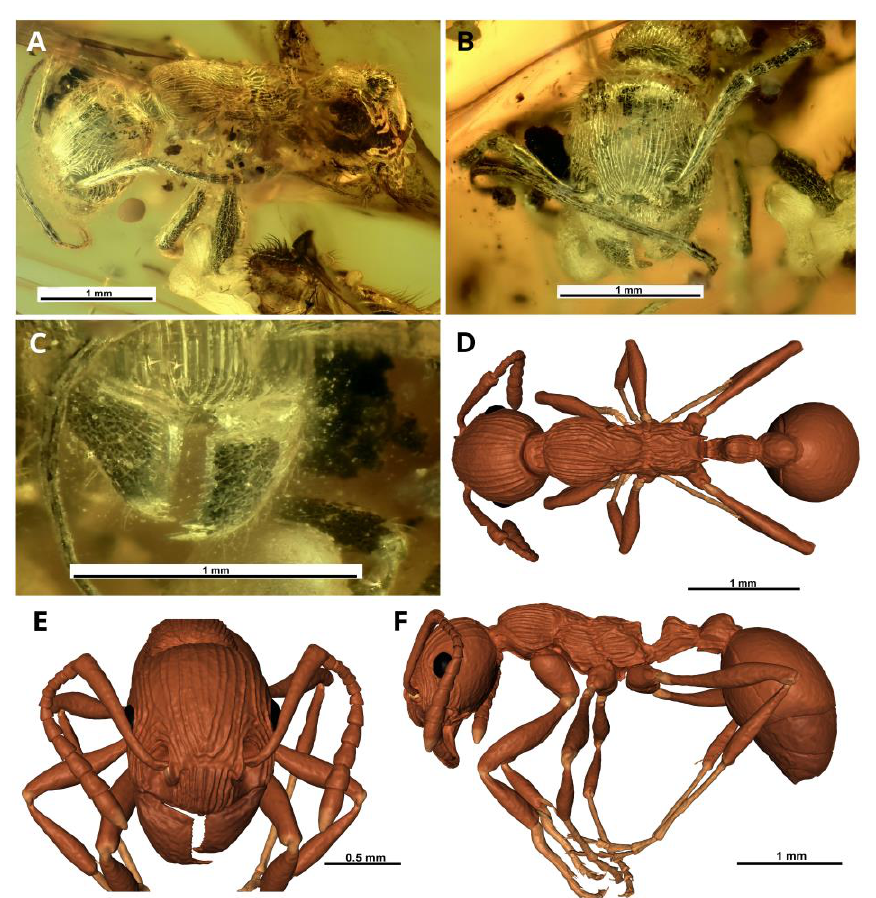
Figure 2. † Manica andrannae sp. nov., holotype, photomicrographs ( A – C ) and paleontological reconstruction (3D models) ( D – F ). Worker: A , F — habitus, left lateral view; B , E — head, frontal view; C — clypeal margin and mandibles; D — habitus, dorsal view.